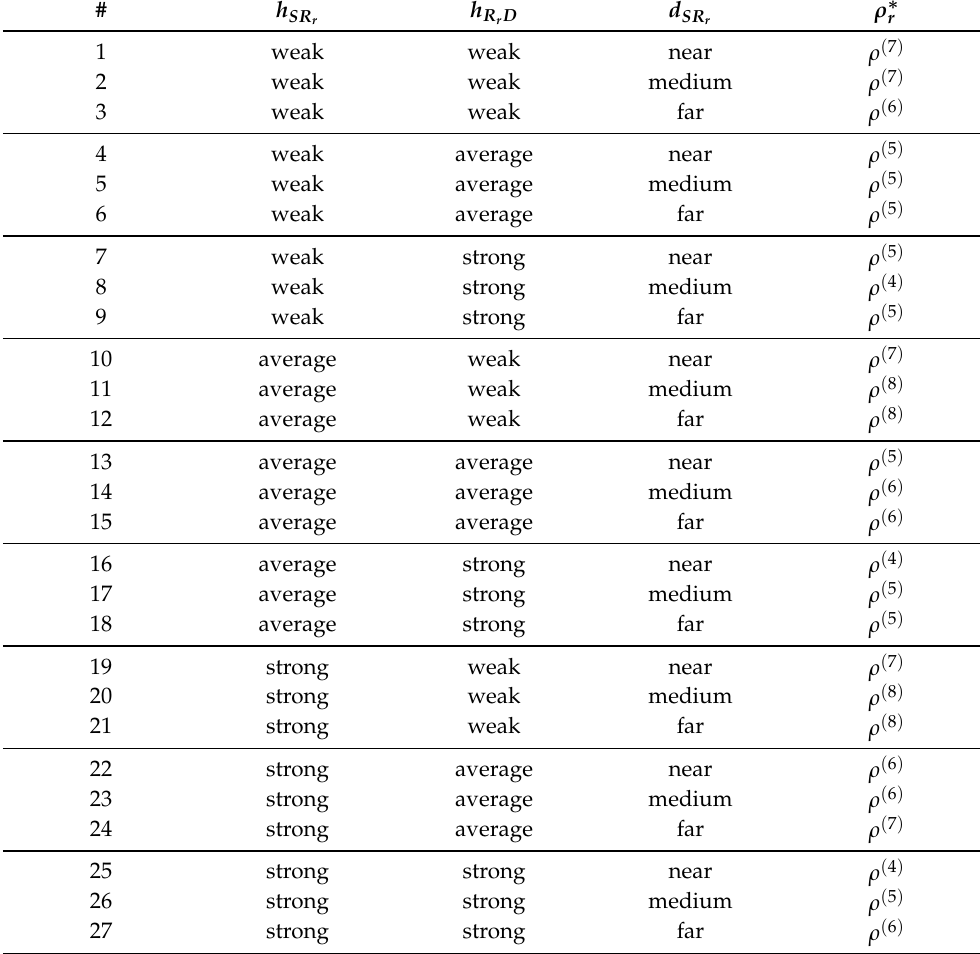
Table 1. Collection of fuzzy